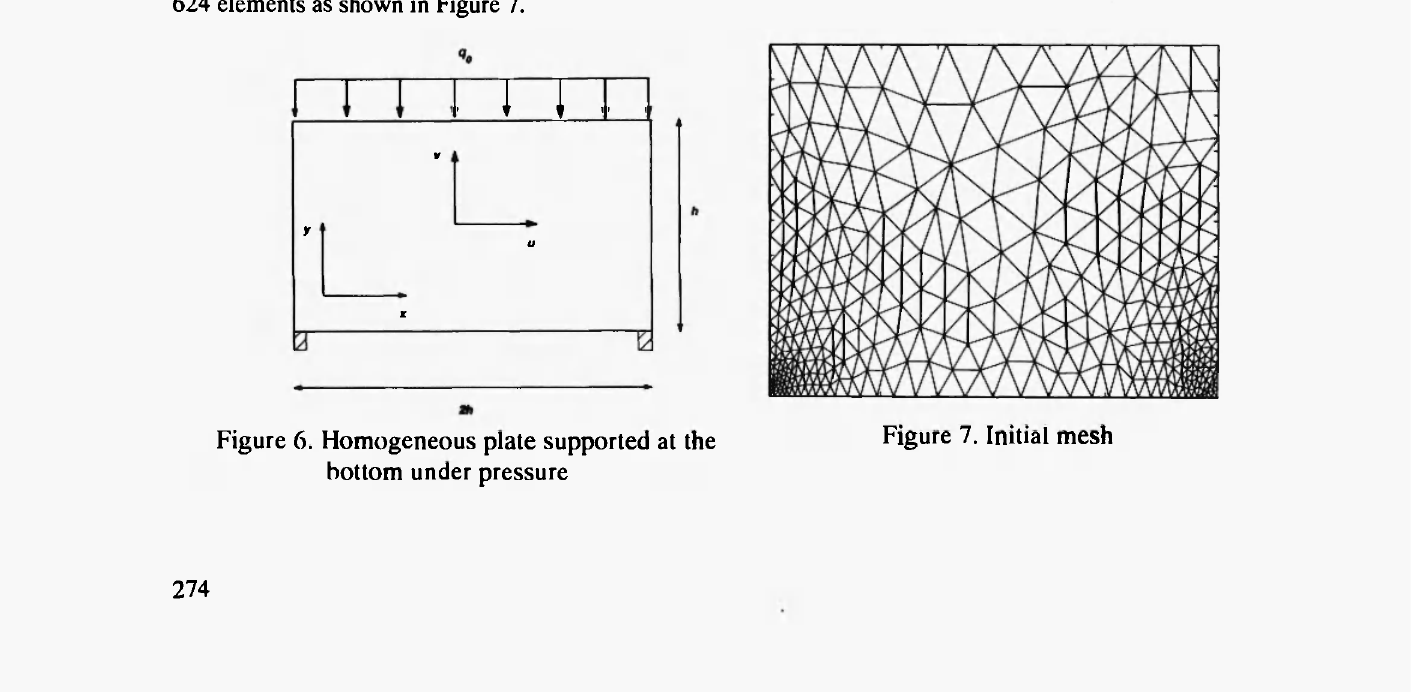
Figure 6. Homogeneous plate supported at the bottom under pressure